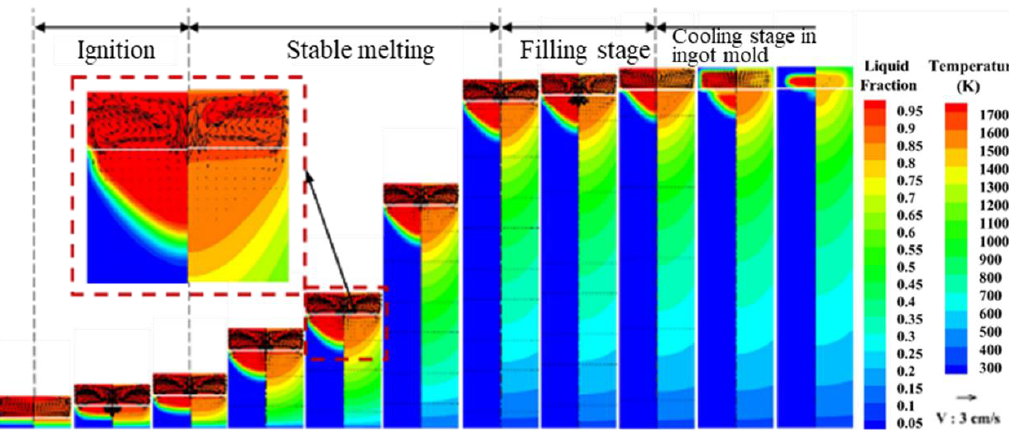
Figure 1. Temperature field, velocity field and molten pool morphology distribution.